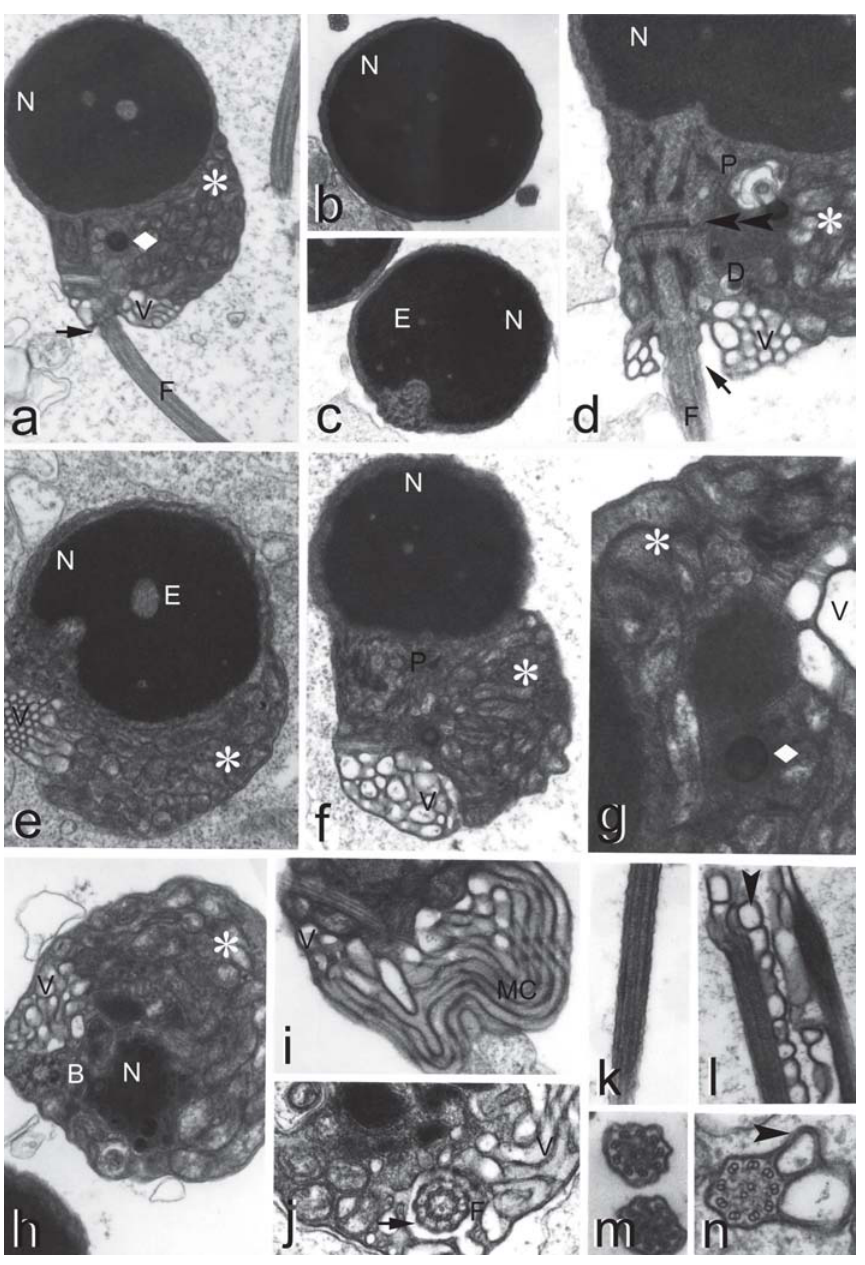
Fig. 4. Spermatozoa of Corydoras aeneus . a ) Longitudinal section. b and c ) Nucleus in cross sections. d ) Detail of centriolar arrangement. e to j ) Midpiece longitudinal and transverse sections showing mitochondria, vesicles, membranous compartment, and electron-dense circular structure. k and l ) Flagellum in longitudinal sections. m and n ) Flagellum in cross sections. ( a, d ) X 17000; ( b ) X 13800; ( c ) X 15750; ( e, h, k, l ) X 23000; ( f ) X 20400; ( g ) 44100; ( i, j ) X 31500; ( m ) X 47250; ( n ) X 57500. B: basal body; D: distal centriole; E: electron-dense structure; F: flagellum; N: nucleus; P: proximal centriole; V: vesicles; Asterisk: mitochondria, Arrow: cytoplasmic channel; Arrowhead: lateral membranous compartment; Double arrowhead: electron-dense material between the centrioles; Lozenge: electron-dense circular